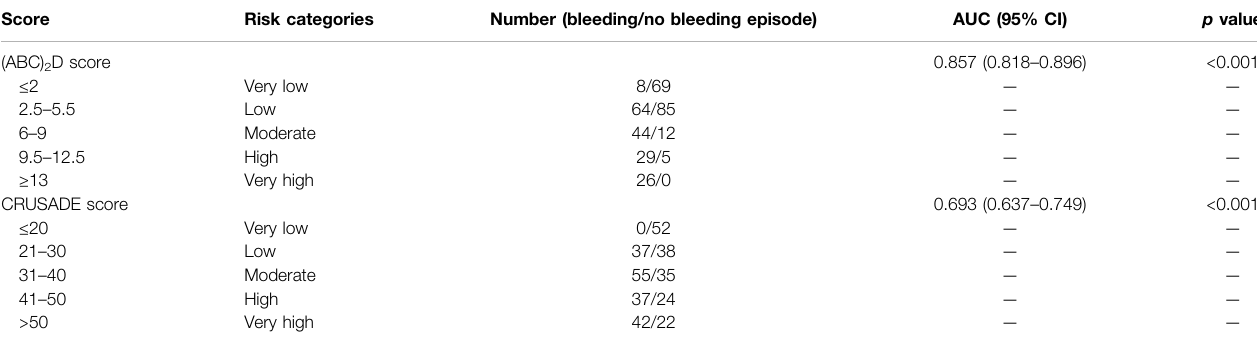
TABLE 3 | Comparison of the predictive ability and performance of the (ABC) 2 D score and the CRUSADE